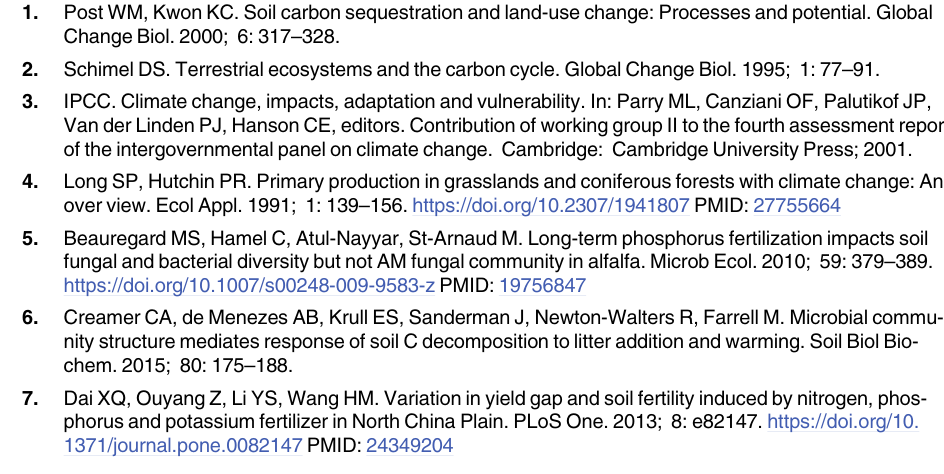
S1 Table. Cumulative mineralization of soil organic carbon for 30 days and variance analy- sis. S2 Table. Environmental factors data and operational taxonomic unit (OTU) based Phy- lum